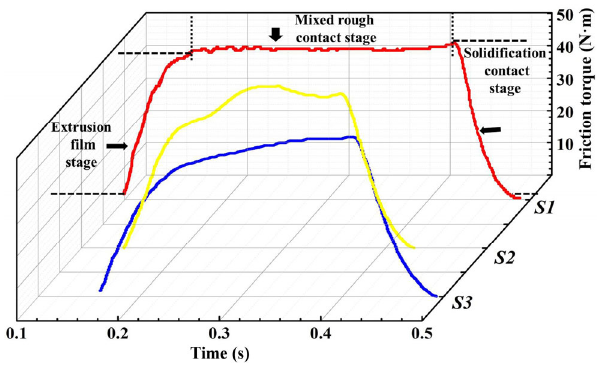
Fig. 7 Friction torque curves of different